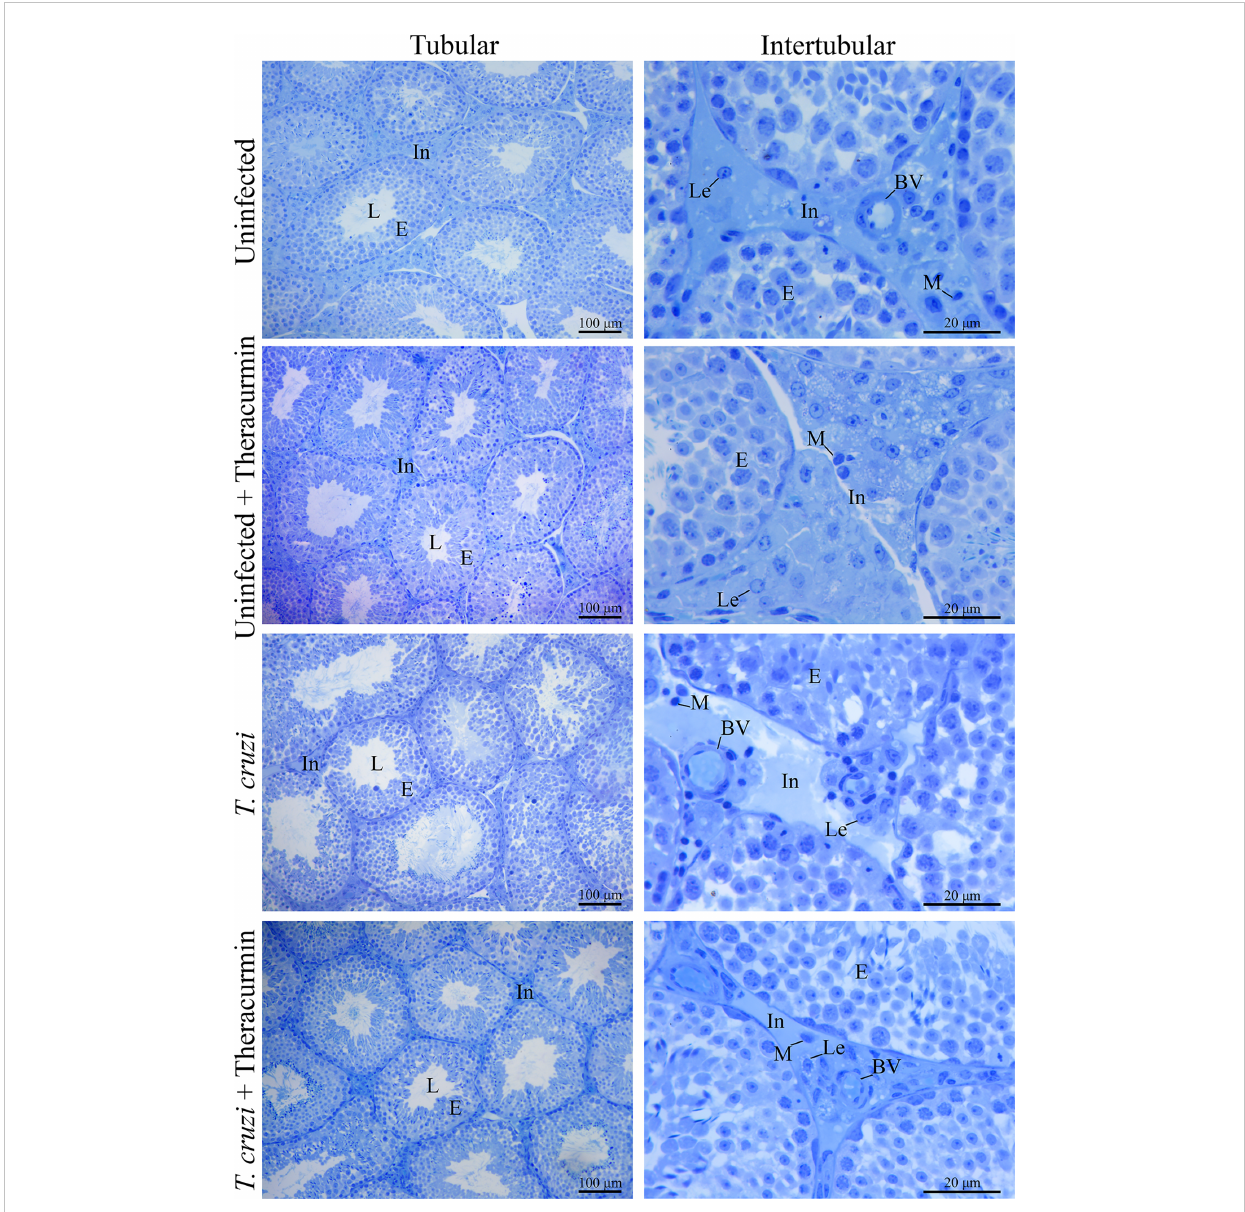
FIGURE 2 Histological images of testicles of Swiss mice infected with T. cruzi and treated with Theracurmin. Animals (n = 28) were grouped as (i) uninfected (n=7), (ii) uninfected + Theracurmin (n=7), (iii) T. cruzi (n=7), and (iv) T. cruzi + Theracurmin (n=7). At the second day after the beginning of the treatment, mice were intraperitoneally infected with 1000 trypomastigote forms of Colombian strain of T. cruzi . After 30 dpi testicles were fi xed, embedded in glycol methacrylate resin, and cut into 3 mm thick sections. The sections were stained with toluidine blue. The volumetric proportions of the tubular and intertubular area were estimated with the count of 266 dots in 10 aleatory fi elds and, the volumetric proportions of the intertubular components were estimated with the count of 1000 dots projected in captured images of the intertubular area in different histological slides of each animal. In, Intertubular area; L, Lumen; E, Epithelium; Lc, Leydig cell; BV, Blood vessel; M,